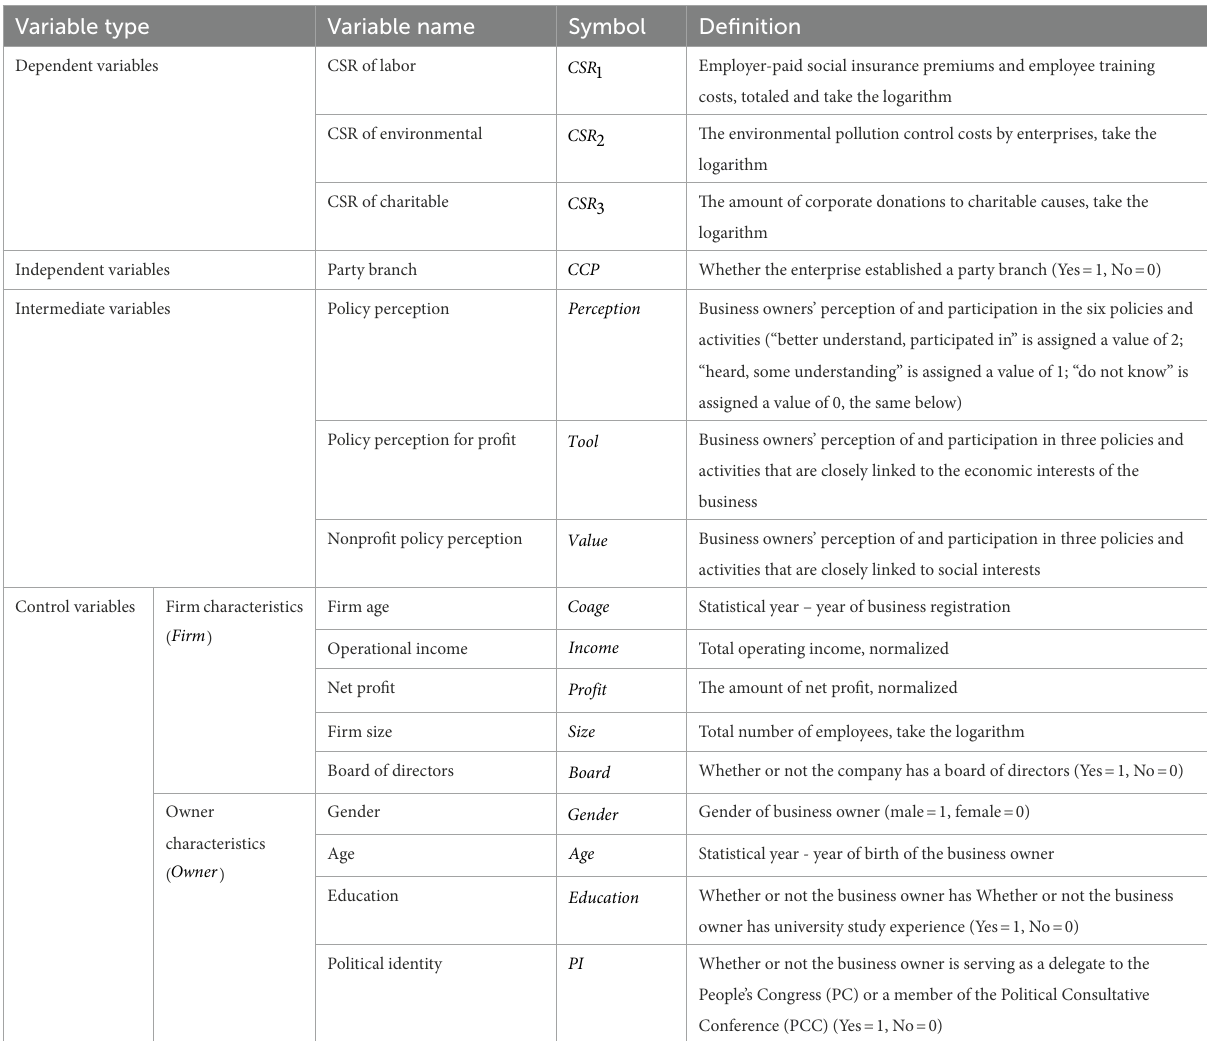
TABLE 1 Variable